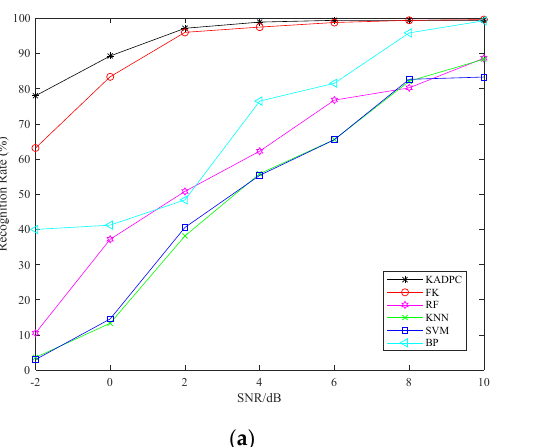
Figure 4. The noise reduction visualization result of BPSK at SNR = 0 dB.